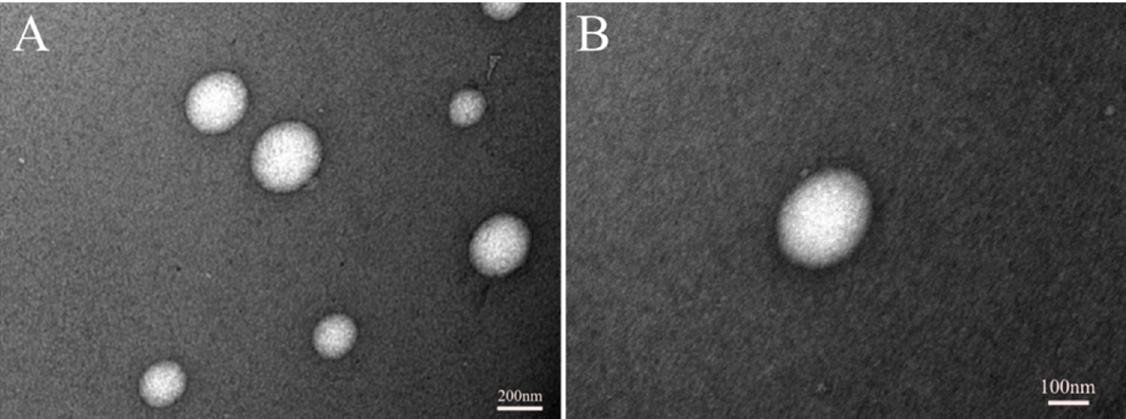
Figure 1. TEM Images of 2C5-modified mixed dendrimer micelles (2C5-MDM-DR), ( A ) 10,000× magnification, ( B ) 20,000× magnification.